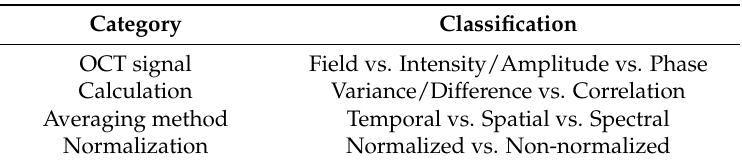
Table 2. Classification of OCTA